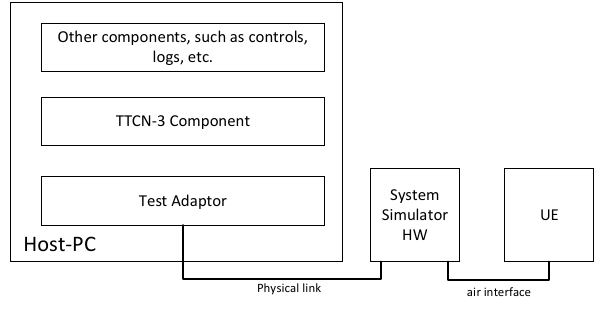
Figure 4. Test System Architecture Based on TTCN-3 [57].